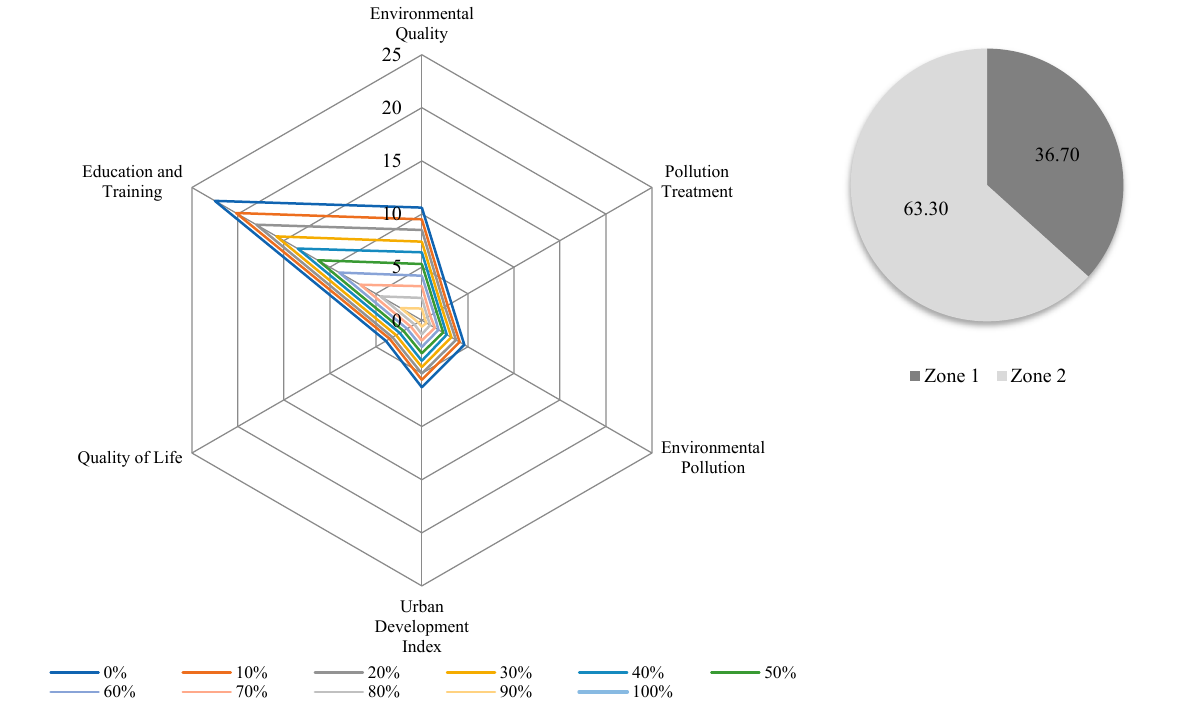
Figure 9. Sensitivity study and alternate percentages of the urban landscape on a radar graph (Zone 1: Barat Daya, Zone 2: Timor Laut).